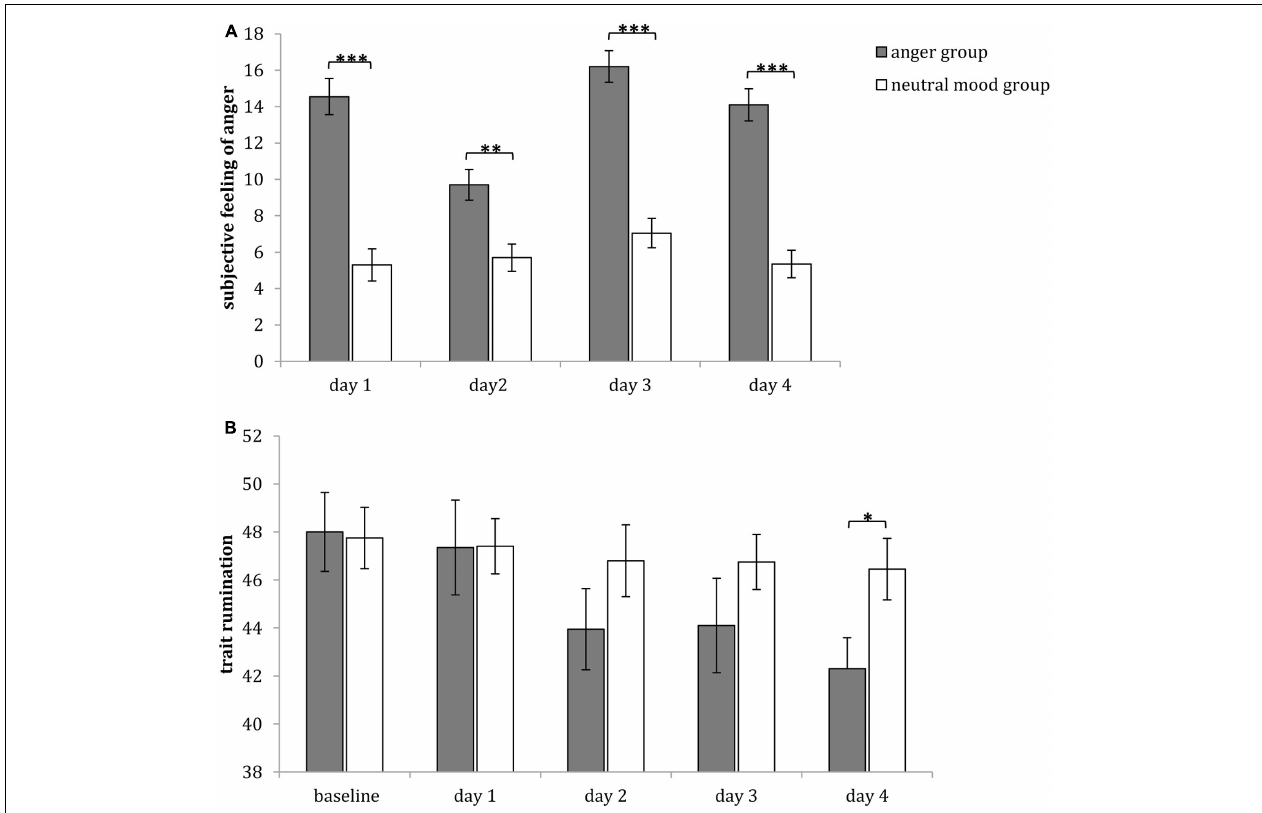
FIGURE 5 | Comparisons of subjective feelings of anger (A) and trait rumination (B) after anger or neutral mood intervention each day in Study 2. Error bars (capped vertical bars) represent (–1)/(+1) SE . ∗∗∗ p < 0.001, ∗∗ p < 0.01, ∗ p <